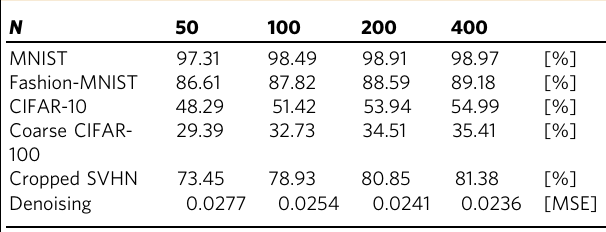
Table 2 Fit-DNN performance for classi fi cation and denoising tasks depending on the number of nodes per hidden layer N .